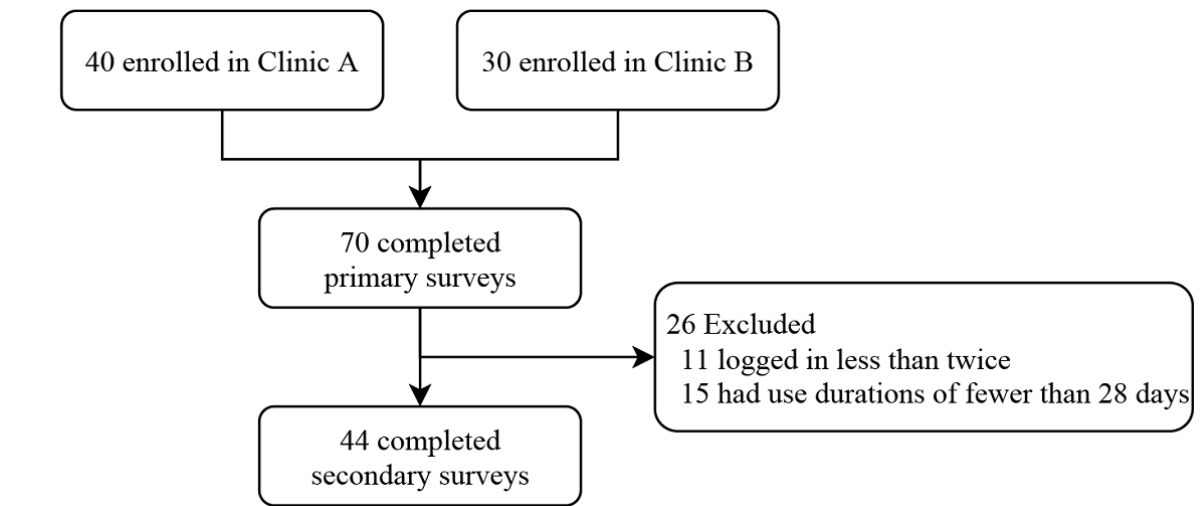
Figure 2. Flow diagram of study